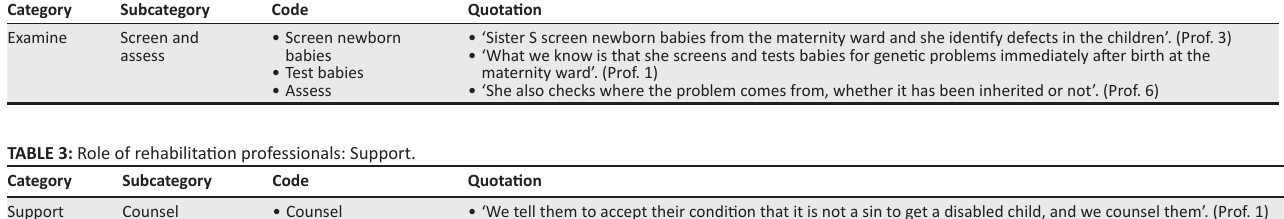
TABLE 2: Role of rehabilitation professionals: Examine. Category